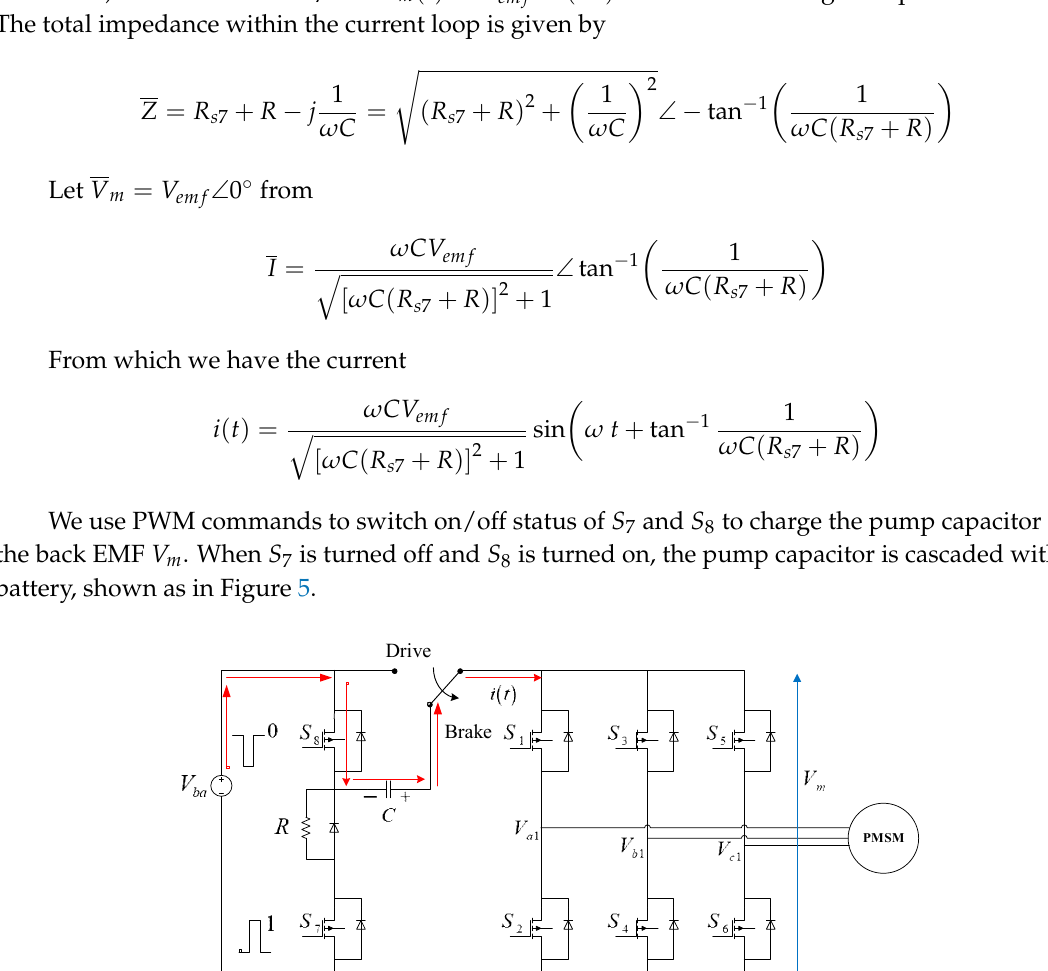
Figure 4. Capacitor charging loop.